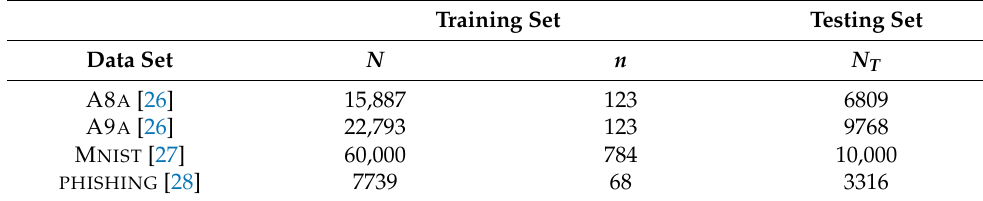
Table 1. Data sets